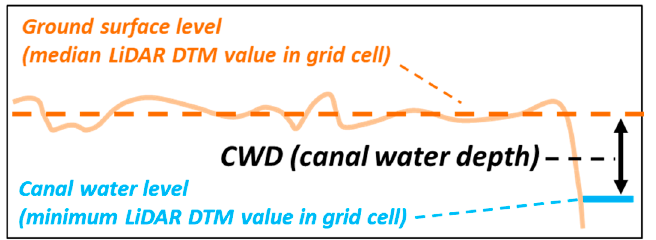
Figure 3. Schematic of how canal water table depth (CWD) was determined from a LiDAR-based digital terrain model (DTM) as the elevation difference between soil surface (median value of DTM values in grid cell) and canal surface water level (minimum value of DTM values in grid cell).